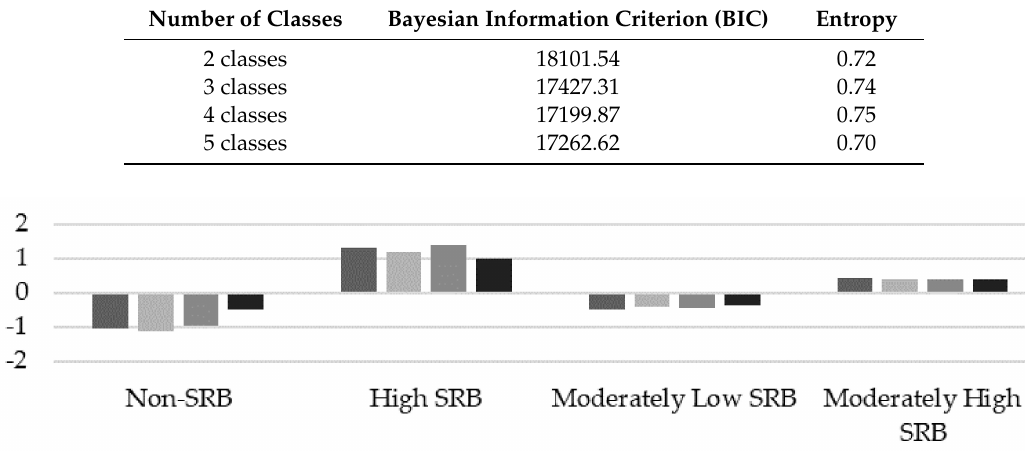
Figure 1. School refusal behavior (SRB)